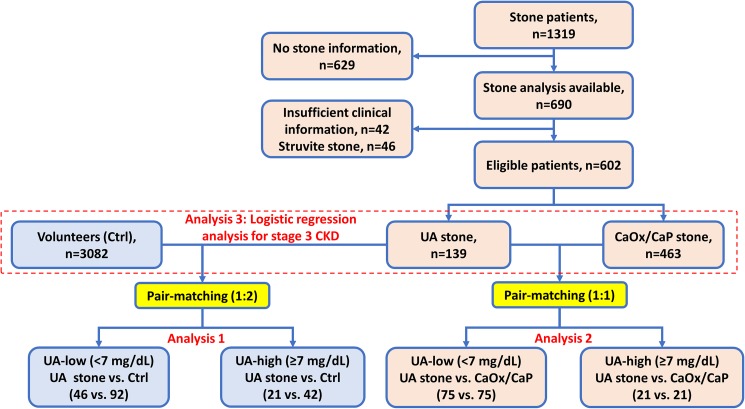
Patient selection and classification.Eligible patients with urinary stones and control subjects selected from the database. We excluded 629 patients without stone analysis, 42 patients without complete clinical data, and 46 struvite stones. The remaining 602 urinary stone patients included in the study. The subjects were divided into two groups according to UA levels: the UA-high group with hyperuricemia (UA ≥ 7.0 mg/dL) or the UA-low group with normal UA levels (UA < 7.0 mg/dL). The control subjects and stone patients were pair-matched according to age, sex, body mass index, comorbidities (HTN, DM and CVD), hyperlipidemia hemoglobin, serum Alb, and serum UA levels using propensity score matching.